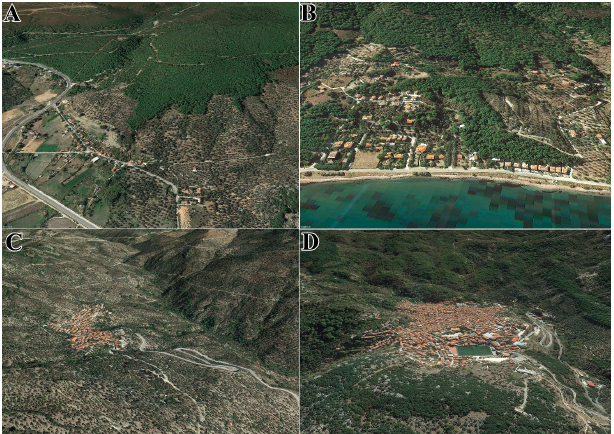
Figure A6. The typology of fuels around the communities of Lesvos Island: ( A ) agricultural encroachment and conifer deforestation; ( B ) high-amenity wildland–urban interface inside dense conifers and olive cultivations; ( C ) olive monoculture; ( D ) mixed broadleaves with conifers, shrubs, and orchards (source: Google Earth).